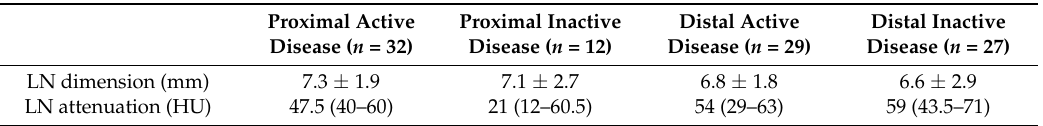
Table 3. Comparison of lymph node characteristics among the subgroups according to the disease extension and activity of